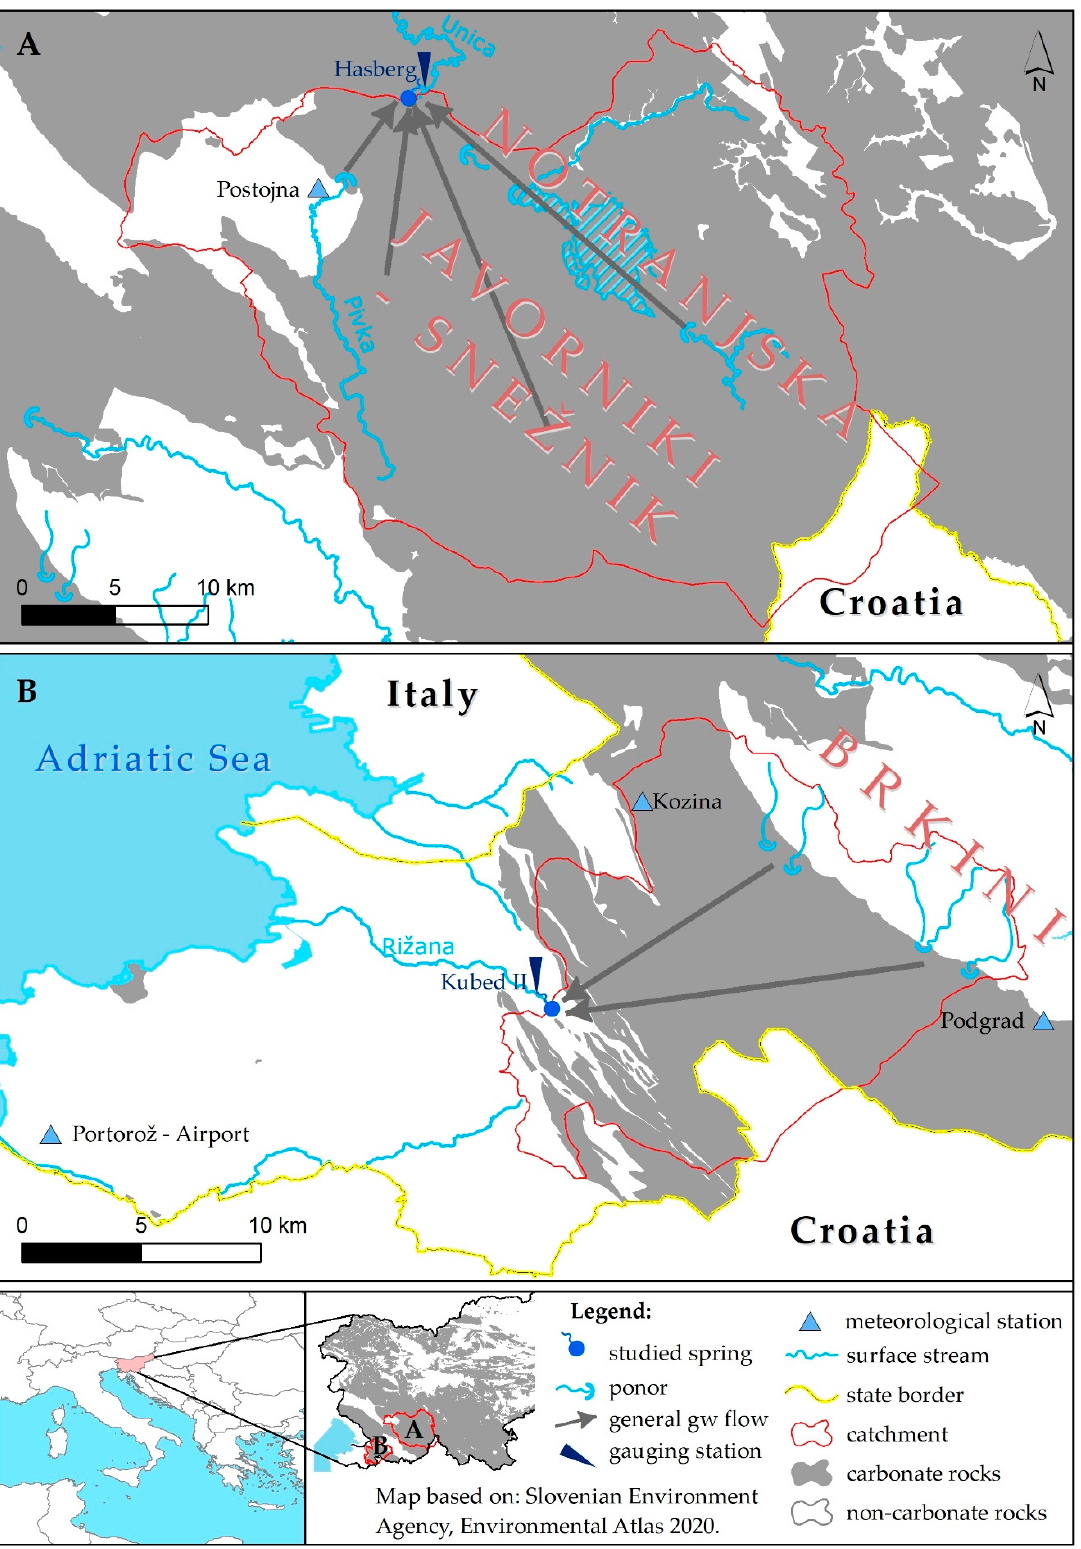
Figure 1. Location and main hydrogeological characteristics of the study areas: ( A ) catchment of the Unica springs, ( B ) catchment of the Rižana spring.